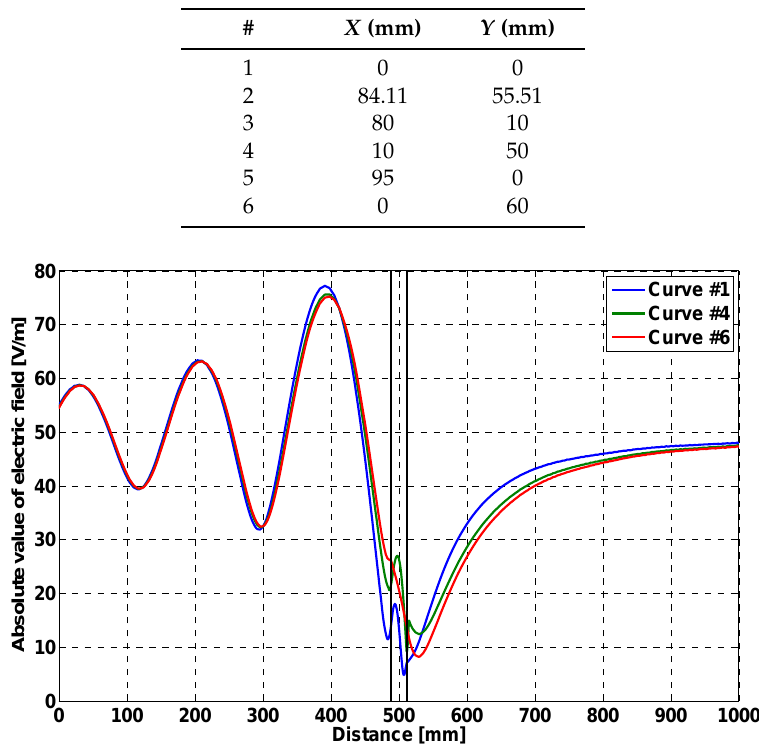
Table 1. Segment positions.